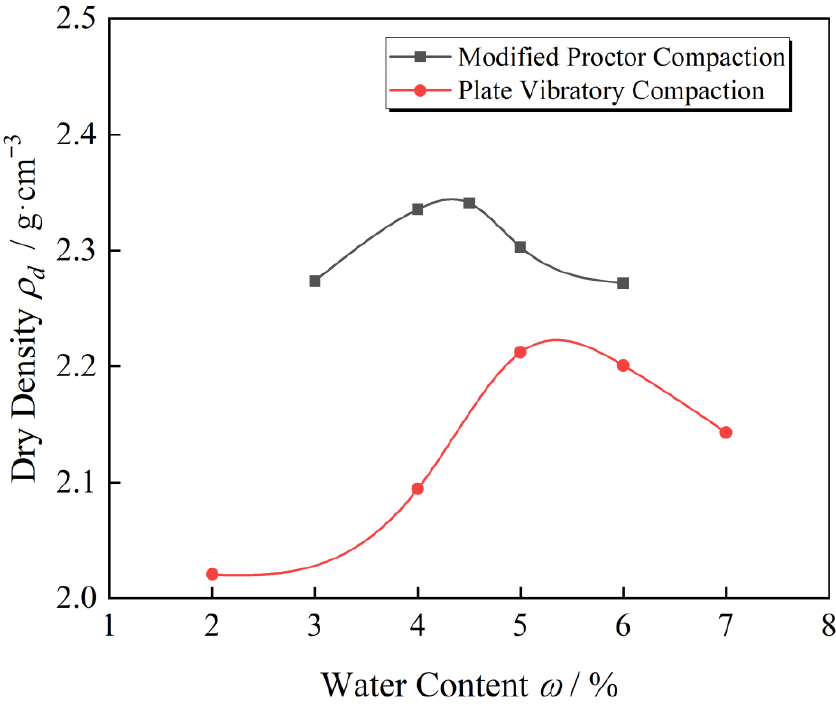
Figure 12. Compaction curves of UPAB specimens with G / S = 1.6 from different laboratory compac- tion methods. Table 5. Compaction results of UPAB specimens with G / S = 1.6 from different laboratory compac- tion methods.